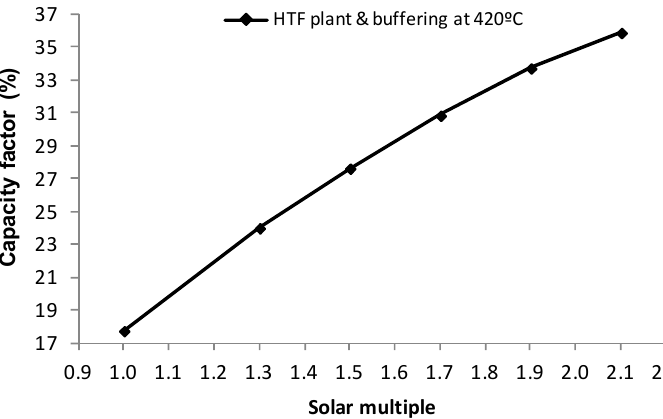
Figure 10. Thermal power plant capacity factor by solar multiple value.